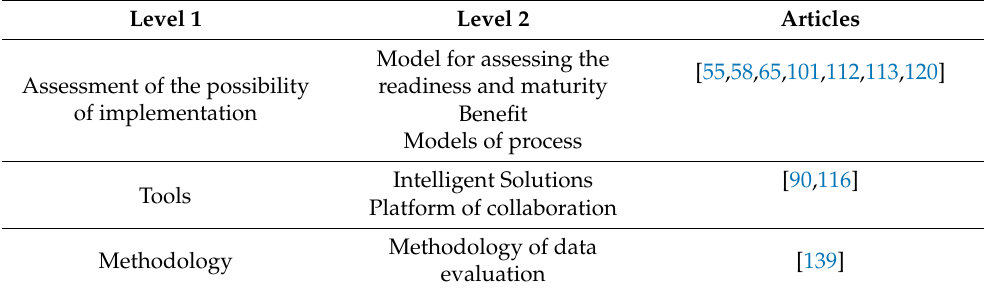
Table 10. The results of classifying the analyzed articles on Logistics 4.0 in the SME sector. Source: own study.